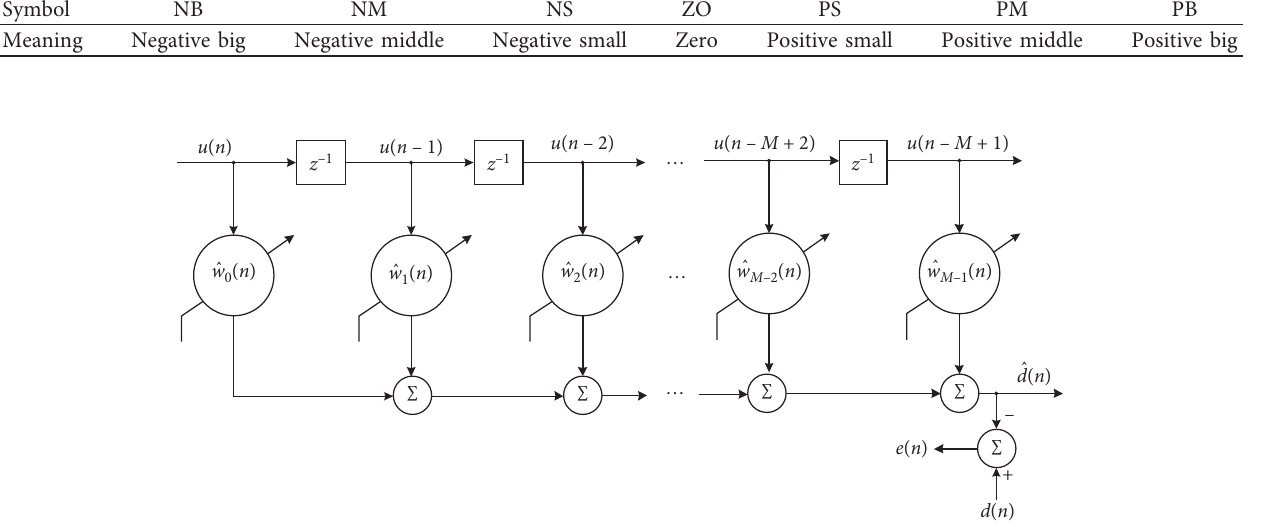
Figure 5: Block diagram of transverse filter